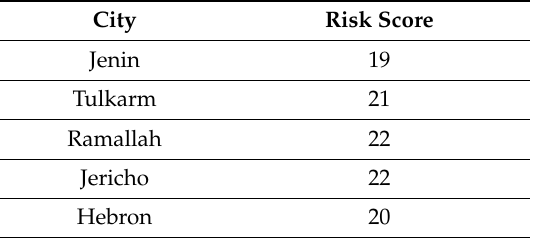
Table 14. Risk score for the water resources (WR) (determined from Tables 7, 8 and 13). City Risk Score